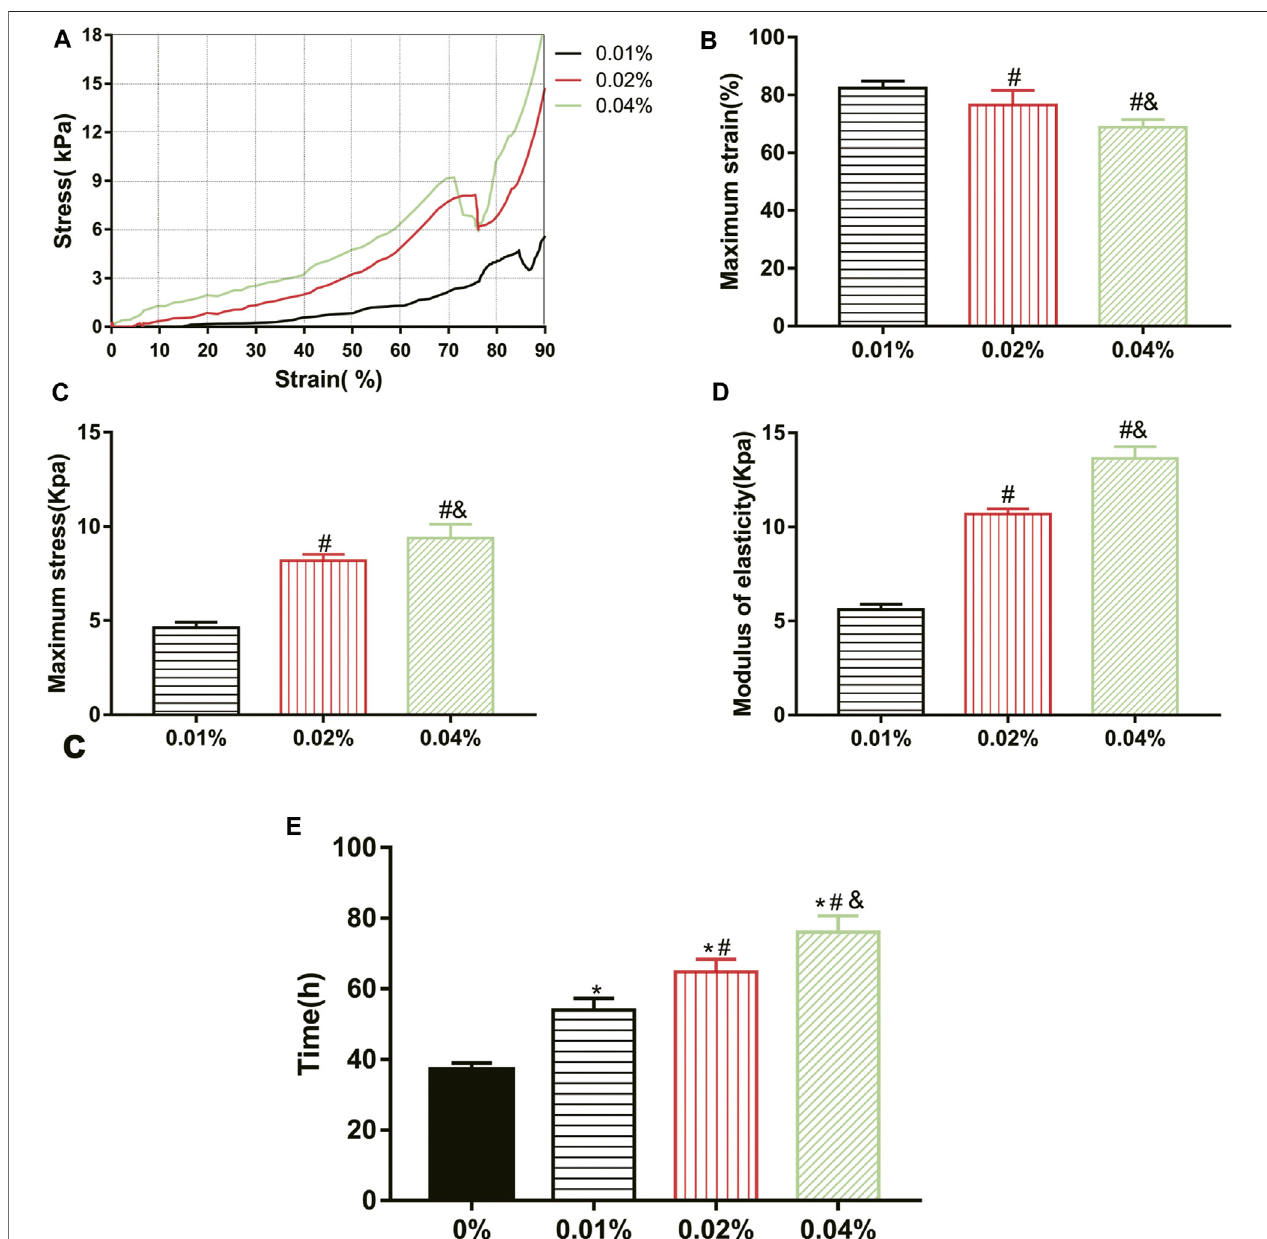
FIGURE 3 | Effect of genipin concentration on GDH cross-linking rule and stability. (A) The stress – strain curves of the GDH hydrogels with different genipin concentrations; (B,C) the maximum strain and maximum stress of the GDH hydrogels with different genipin concentrations; (D) the elastic modulus of the GDH hydrogels with different genipin concentrations; (E) the stability of GDH re fl ected by the time of complete degradation in vitro . Data represented mean ± SD ( n (cid:2) 5); * p < 0.05, vs. 0% group; # p < 0.05, vs. 0.1% group; & p < 0.05, vs. 0.02% group.